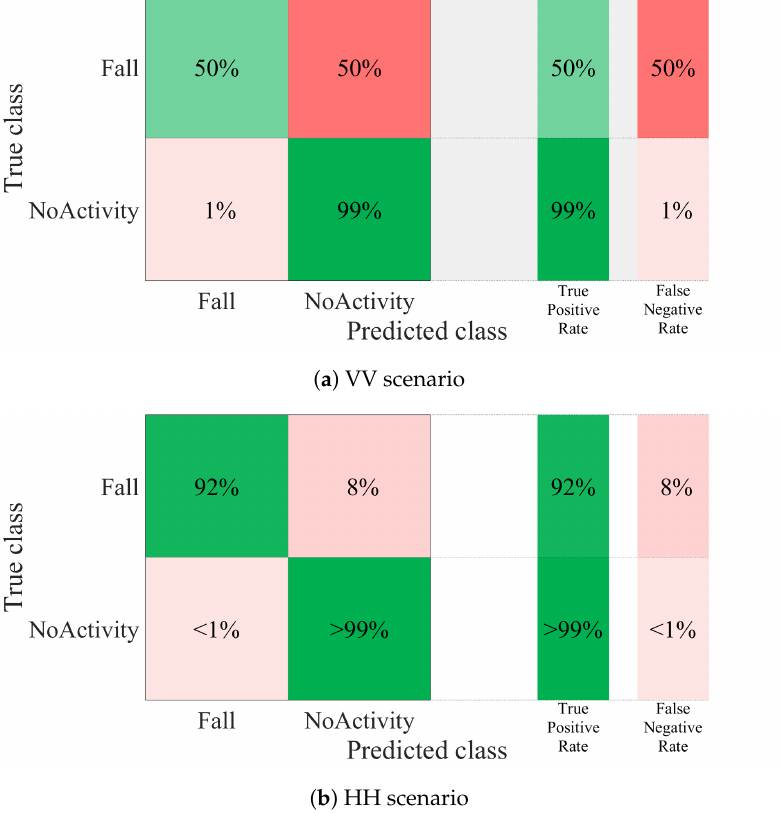
Figure 11. Confusion matrix of the SVM algorithm.